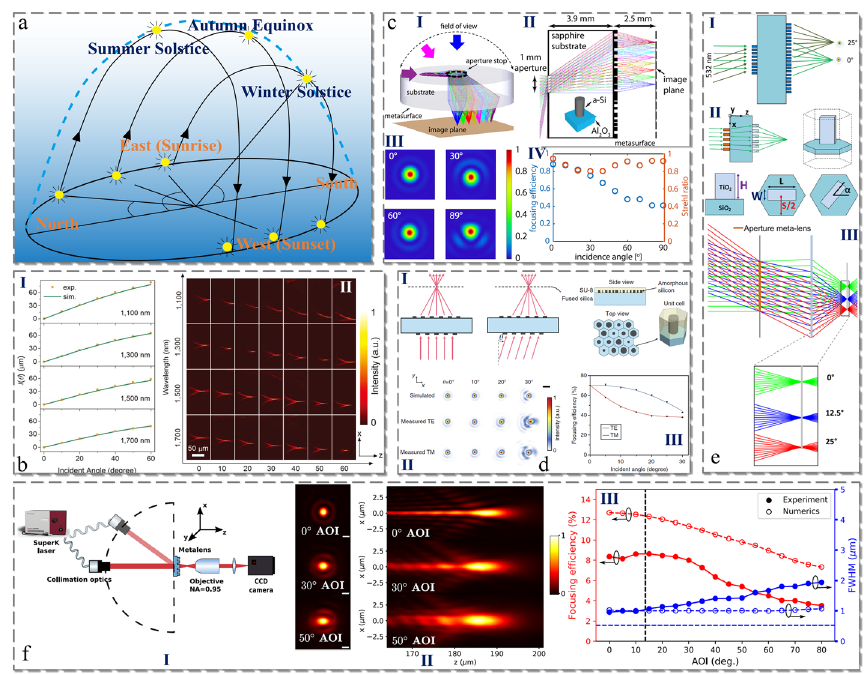
angles of incidence. (d) Schematic of focusing on- and off-axis light by a metasurface doublet lens